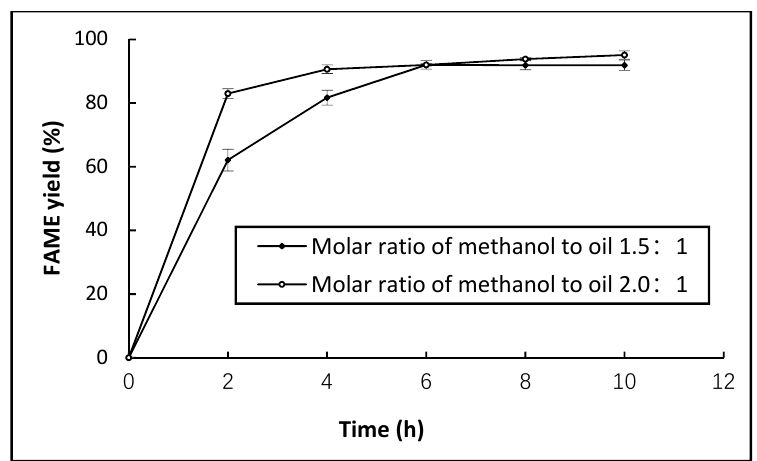
Figure 14. Lipase-mediated methanolysis of hydrolysed microalgae oil for biodiesel production.